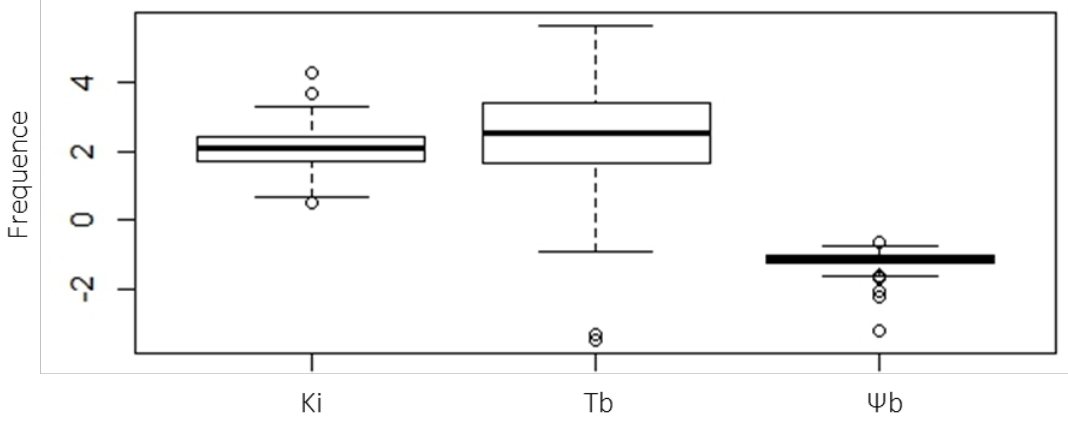
Figure 5. Boxplot presentation of frequency statistical analysis of Ψ b, Tb and Ki values of the 44 genotypes.